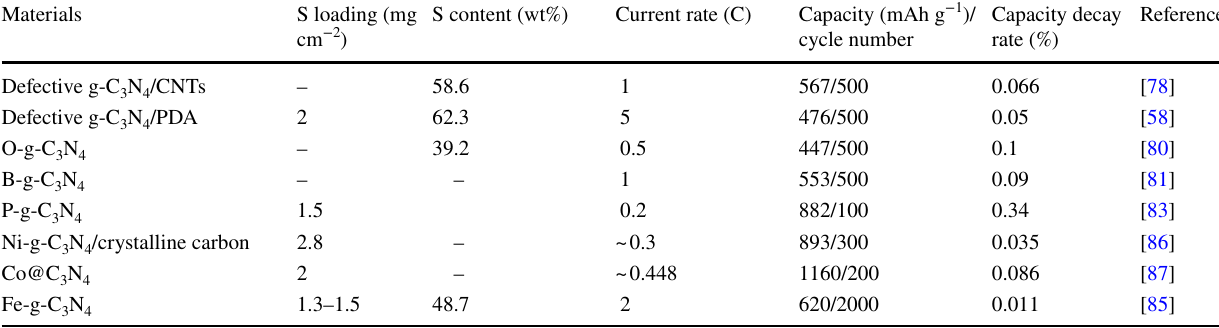
Table 1 Comparison of performances of Li–S cells with optimized g‑C 3 N 4 materials Materials S loading (mg